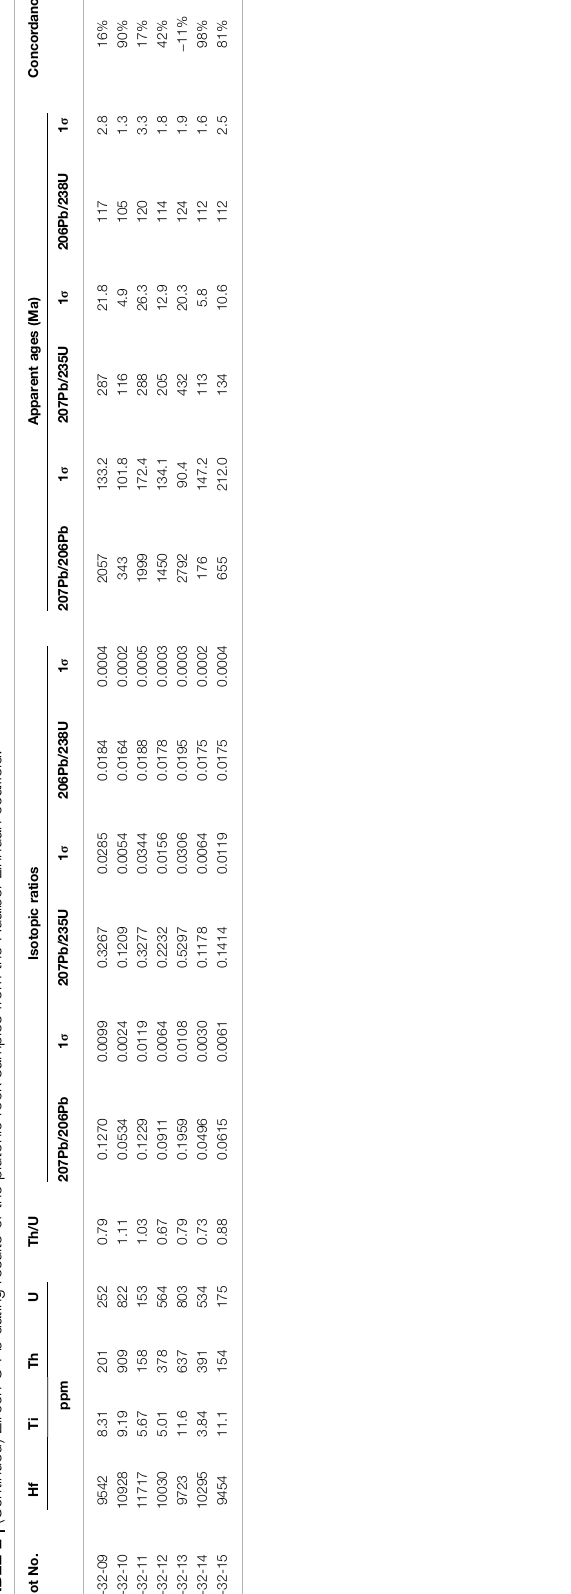
In the Total Alkali-Silica (TAS) diagram, the gabbro-dolerite samples fall inside the (olivine-)gabbro fi elds (some marginally alkali), whilst the diorite-granodiorite samples fall inside the (quartz-)monzonite and syenite fi elds ( Figure 7A ). Similar results are shown in the immobile Zr/Ti vs. Nb/Y diagram, suggesting that alteration/weathering has no major in fl uence on the major element geochemistry ( Figure 7B ). Both the gabbro-dolerite (ASI (cid:1) 0.94 – 1.38) and diorite-granodiorite T A